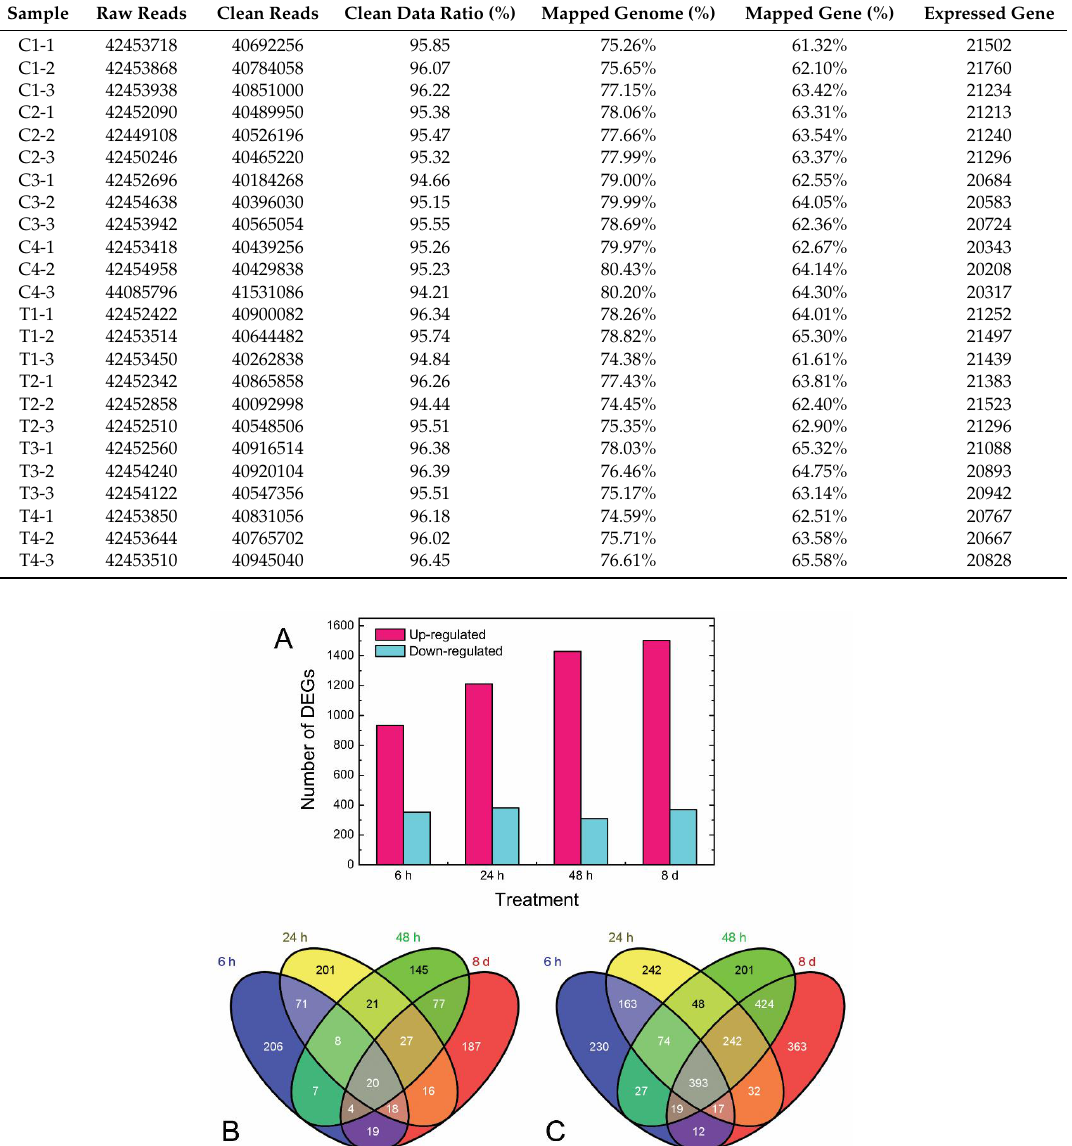
Table 1. Summary of sequencing and mapping results.